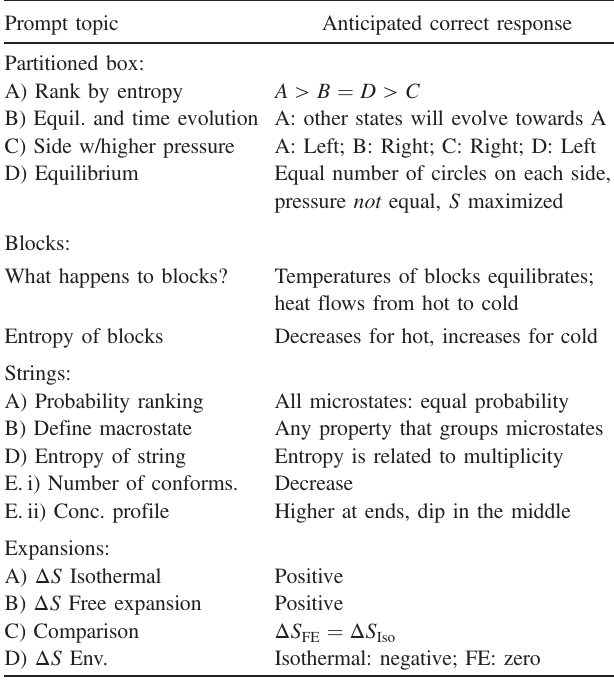
TABLE II. Summary of questions and correct answers to help contextualize student reasoning and